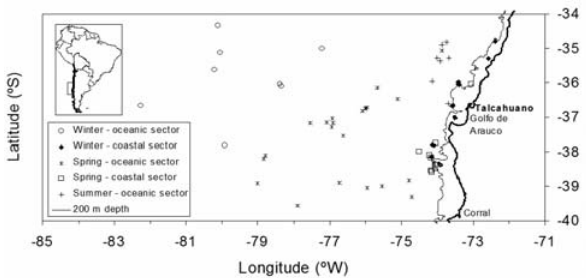
F IG . 1. – Study area, showing the distribution of the fishing sets and towns from which samples of D. gigas were obtained during the study